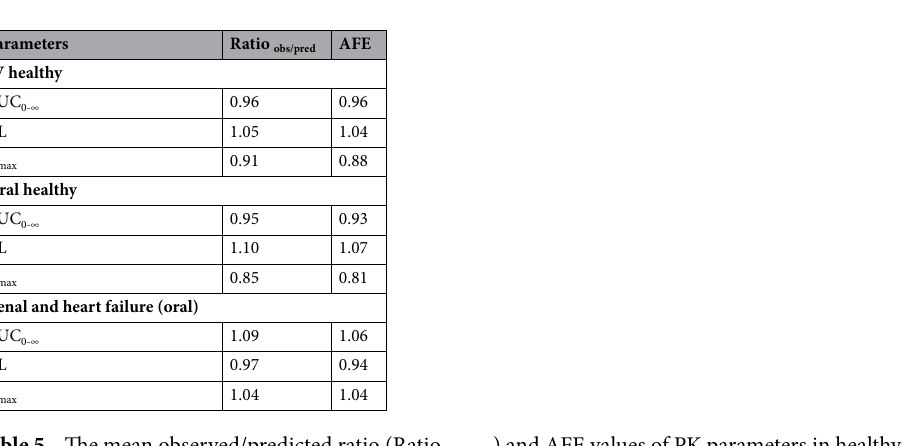
Table 5. The mean observed/predicted ratio (Ratio obs/pred ) and AFE values of PK parameters in healthy and disease population after administration of iv and oral captopril.